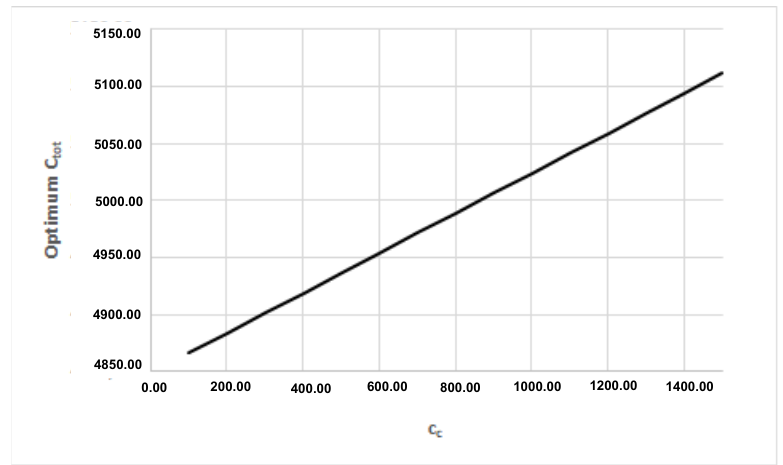
Figure 15. Variations of optimum C tot per c c .